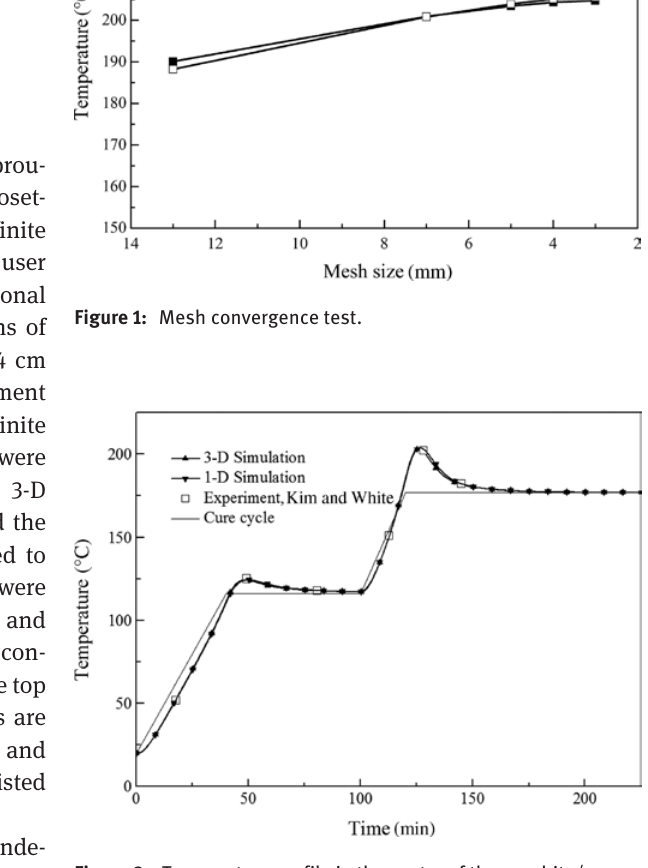
Figure 2: Temperature profile in the center of the graphite/epoxy laminate.